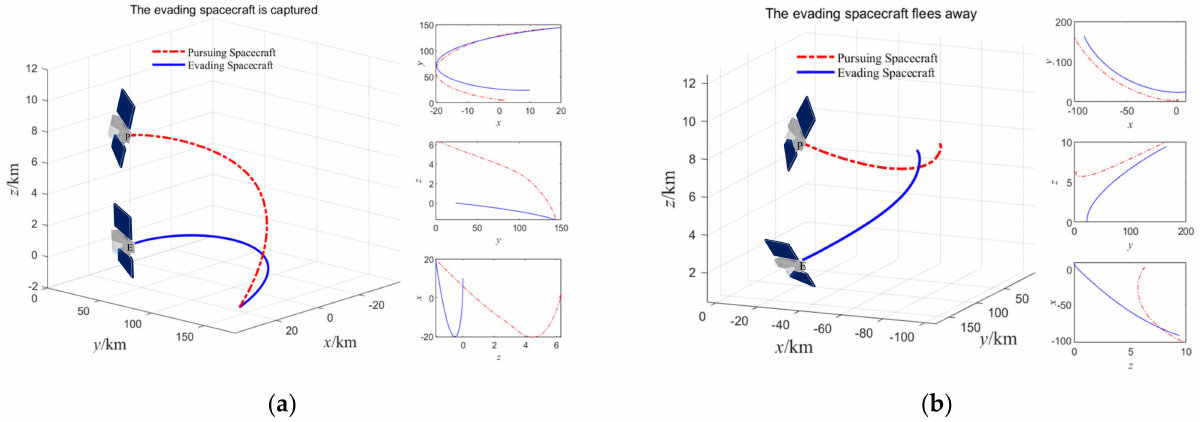
Figure 15. The result based on two sets of initial values of adjoint variables ( a ) the result with λ 0 as input; ( b ) the result with λ (cid:48) as 0